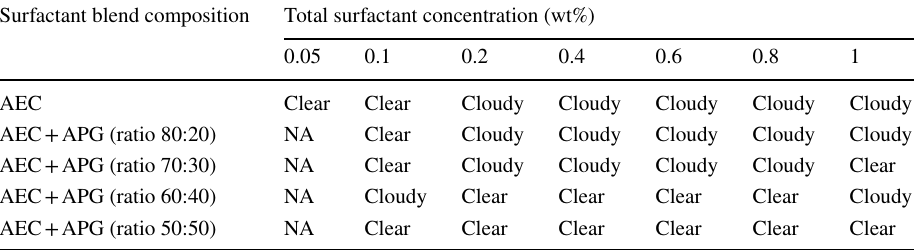
Table 4 Summary result for surfactant solubility at various concentrations and blending ratio after 60 days at 106